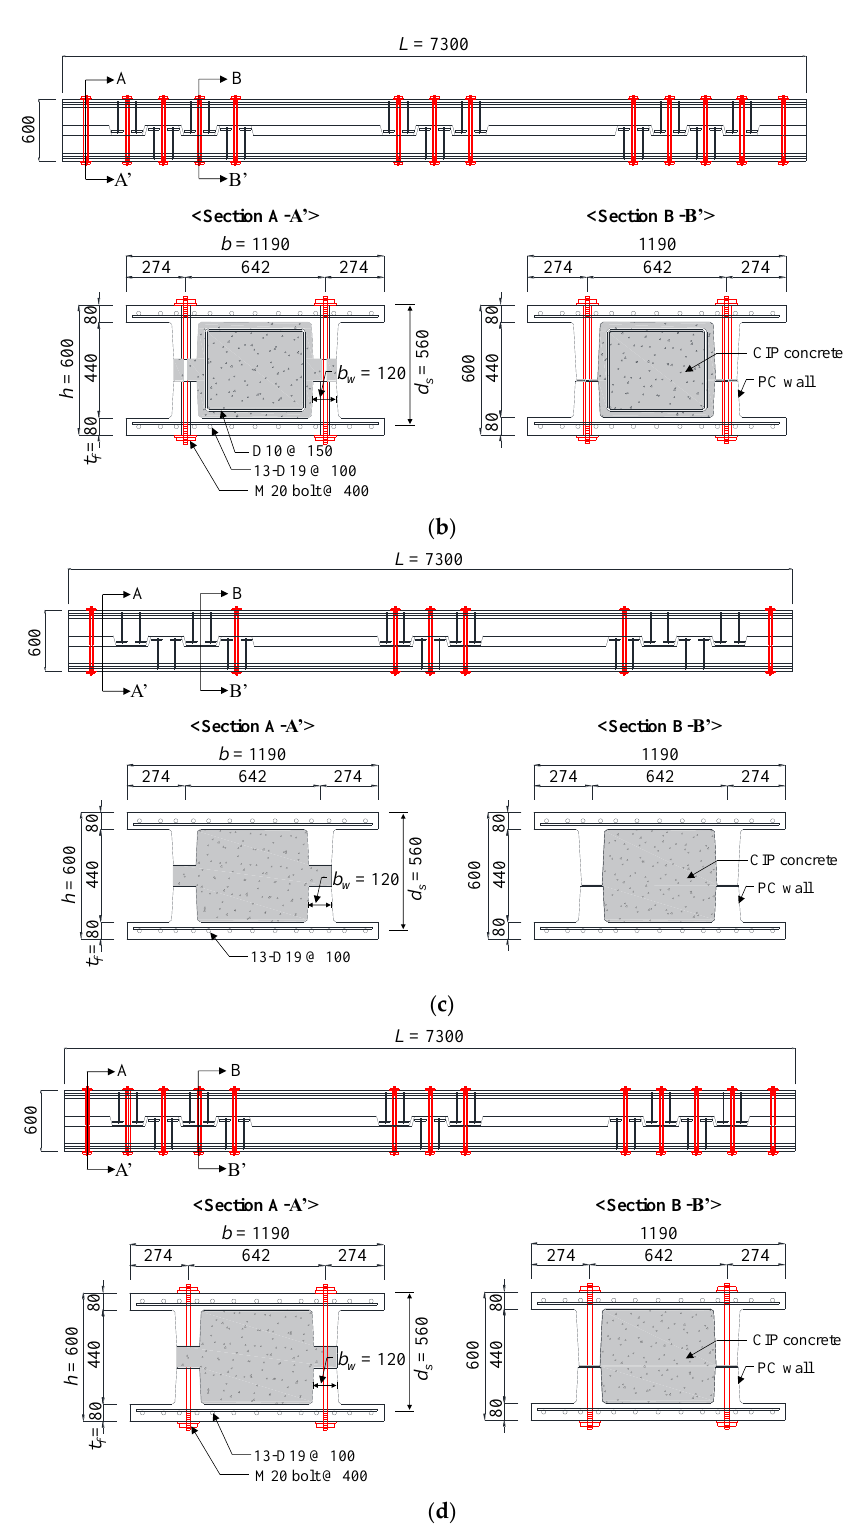
Figure 3. Section details of test specimens (unit: mm): ( a ) specimen naming; ( b ) DCW-F specimen; ( c ) DCW-SN specimen; ( d ) DCW-SB (1) and (2) specimens.